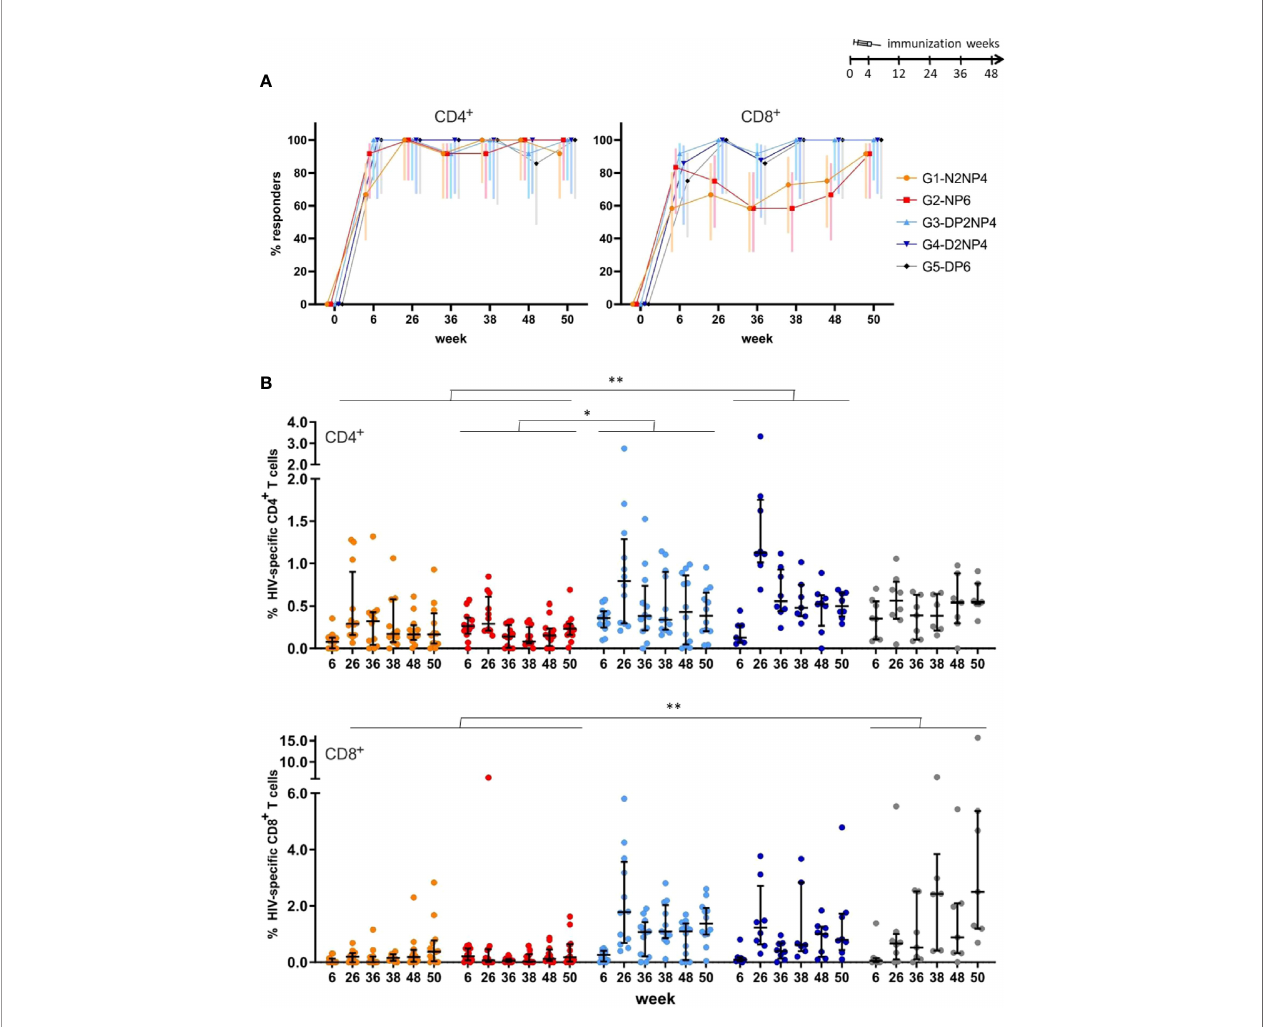
FIGURE 3 | Overall HIV-1-speci fi c CD4 + and CD8 + T cell responses by ICS assay. PBMCs obtained at the indicated time-points were stimulated ex vivo with the nine different HIV-1 peptide pools and stained for CD3, CD4 and CD8 and intracellular IFN- g , IL-2, and TNF. Responding CD4 + and CD8 + T cells were quanti fi ed by fl ow cytometry. (A) Response rate (%) for all cytokines combined with 95% CI for CD4 + (left panel) or CD8 + (right panel) T cells. (B) Magnitude of the HIV-1-speci fi c responses summed up for all the peptide pools and cytokines for CD4 + (upper panel) or CD8 + (lower panel) T cells per animal as colored dots with median and interquartile ranges in black. Statistical signi fi cance was determined using Tukey´s multiple comparisons test. *, p < 0.05; **, p <